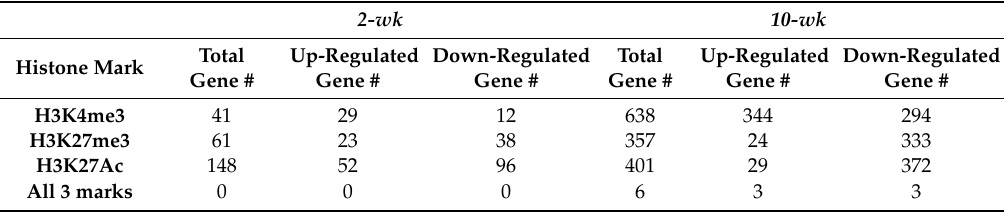
Table 1. The number of genes potentially regulated by histone